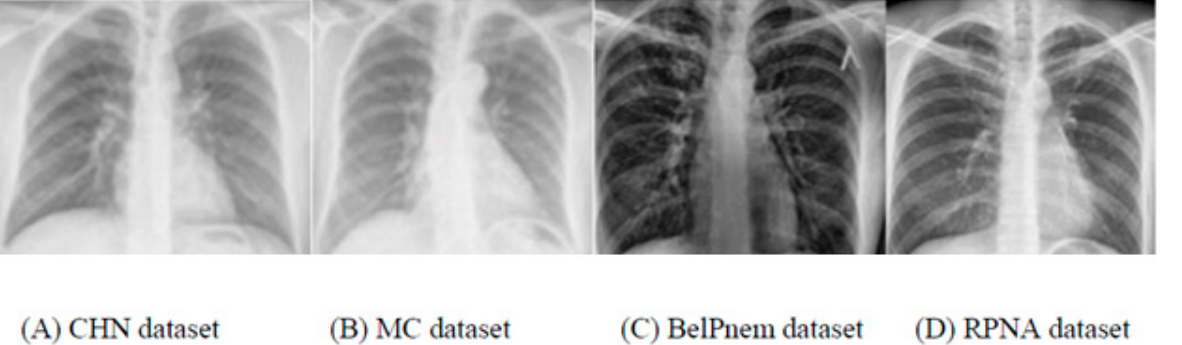
Figure 3. Example of X-rays from the utilized databases. ( A ) CHN dataset, ( B ) MC dataset, ( C ) BelPnem dataset and ( D ) RPNA dataset.